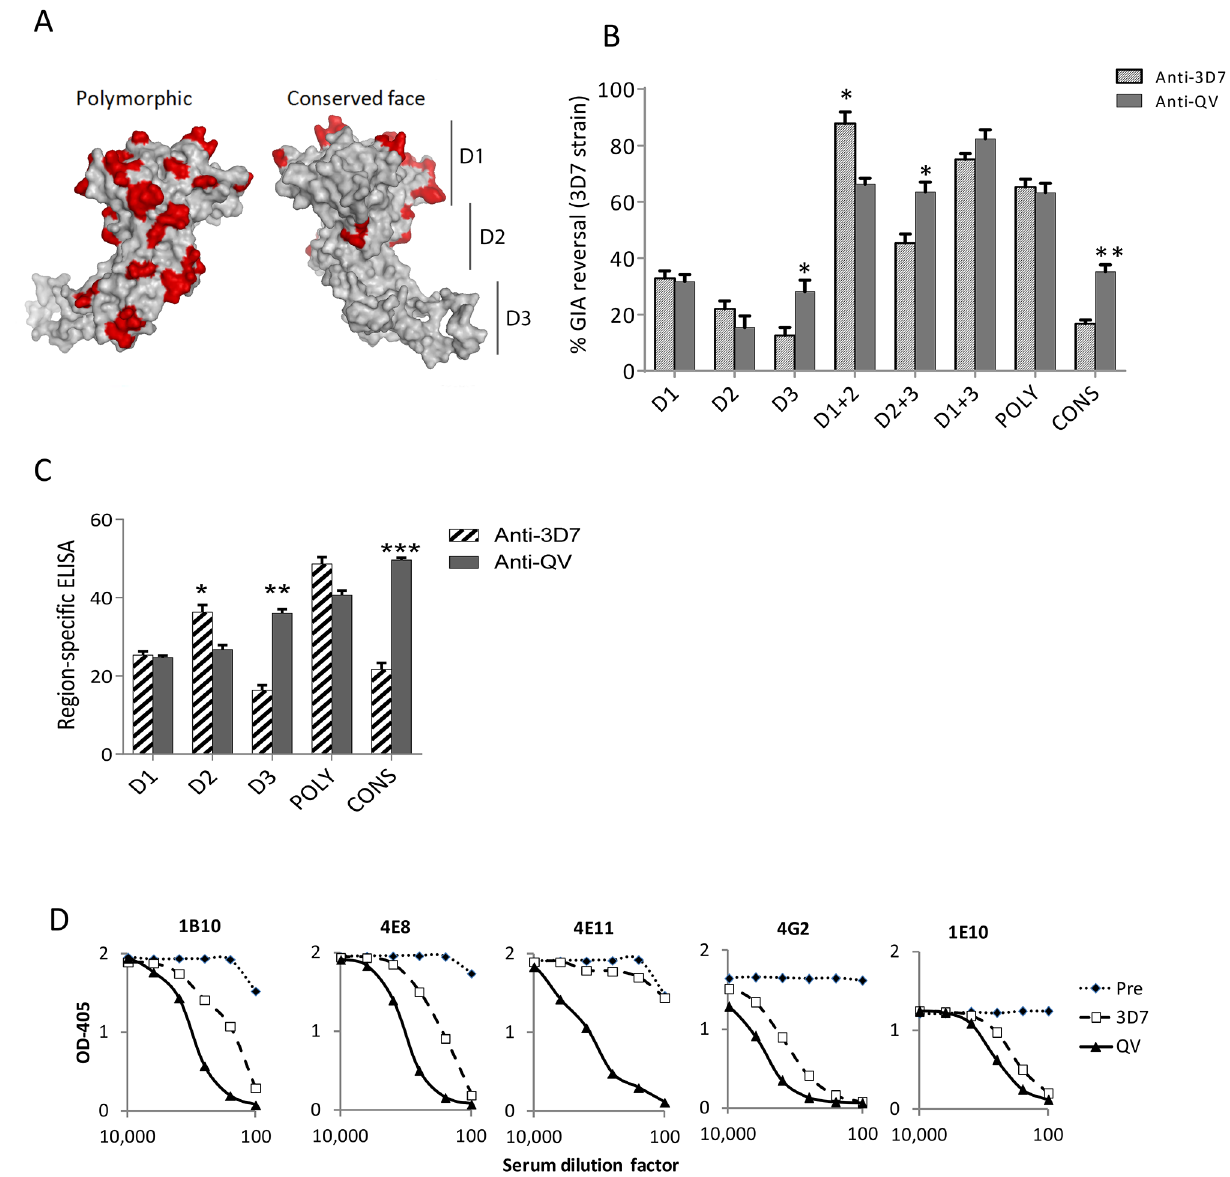
Figure 6. Mapping inhibitory activity of polyclonal antibodies. ( A ) Distribution of high frequency polymorphisms on the three domains (D1, 2, 3), the polymorphic face and the conserved face of AMA1. ( B ) Region-specific inhibitory contributions determined by adding chimeras to reverse anti-3D7 or anti-QV serum pool mediated GIA activity (approximately 60% starting GIA activity) against 3D7 parasites. Reversal using chimeric proteins CryD1, CryD2, CryD3, Cry D1 + CryD2, CryD2 + CryD3, CryD1 + CryD3, POLY and CONS (4 m M, , 200 m g/ml final concentration) was determined with respect to P. berghei AMA1 as the control. Mean + s.e.m. of 3 experiments and (*) indicates statistical significant p value of t-tests comparing anti- 3D7 and anti-QV reversals. ( C ) Region-specific ELISA response with pooled sera (% of total) calculated as the ratios of end-point titers against a 3D7 chimera relative to the end-point titer against 3D7 AMA1 protein (mean + s.e.m. of triplicates in a representative of three experiments). ( D ) Competition ELISA shows the binding of HRP labeled mAbs to heterologous 102-1 AMA1 protein. The mAb binding was competed out using serial dilutions of polyclonal anti-3D7 or anti-QV or pre-immune rabbit serum pools ( x axis ). Shown is mean OD 405 of 2 wells from a representative of two